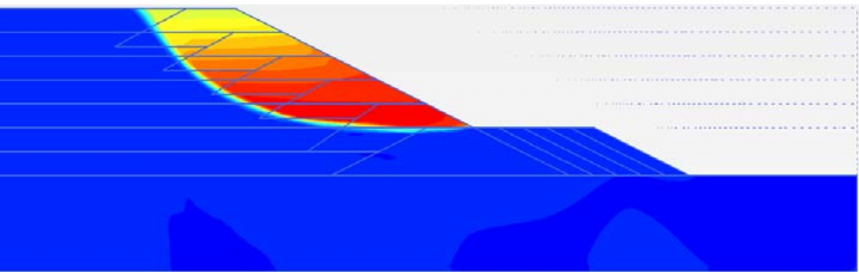
Figure 5. Failure mechanism of the upstream tailings dam (filling rate of 5.0